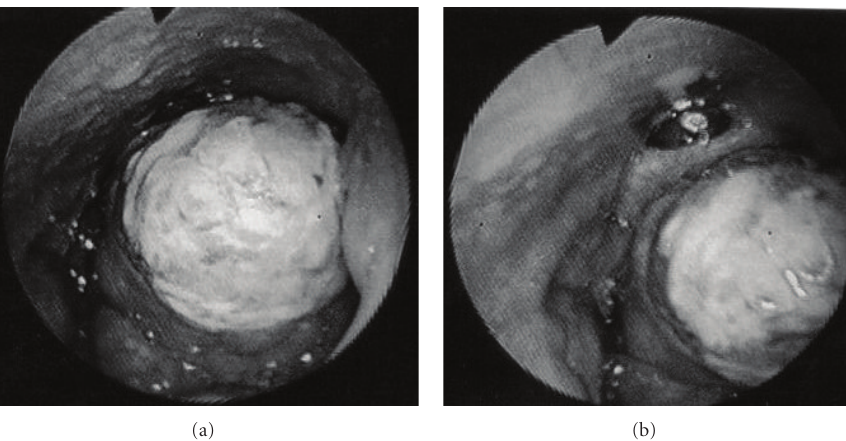
Figure 1: (a) A gigantic tumor, with necrosis on its surface, is seen near the center of the base of the tongue. (b) The airway is almost blockaded and epiglottis is oppressed backward by the tumor.